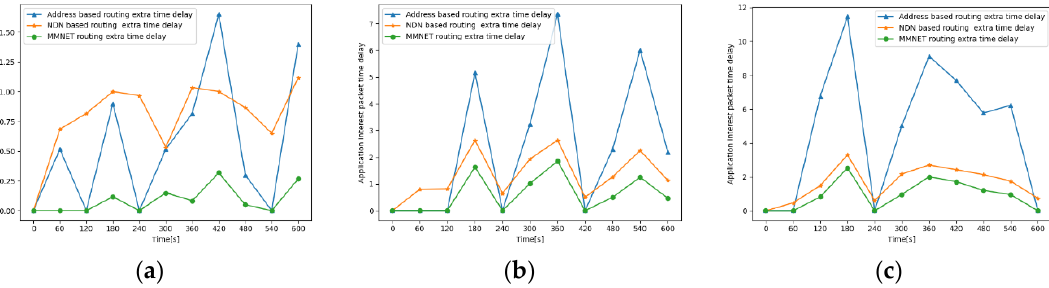
Figure 21. ( a ) Application interest packet extra time delay of three collection nodes; ( b ) application interest packet extra time delay of six collection nodes; ( c ) application interest packet extra time delay of nine collection nodes.